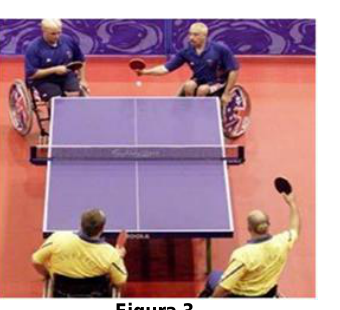
Figura 4. http://garagem.odois.org/wp- content/uploads/2009/06/610x.jpg